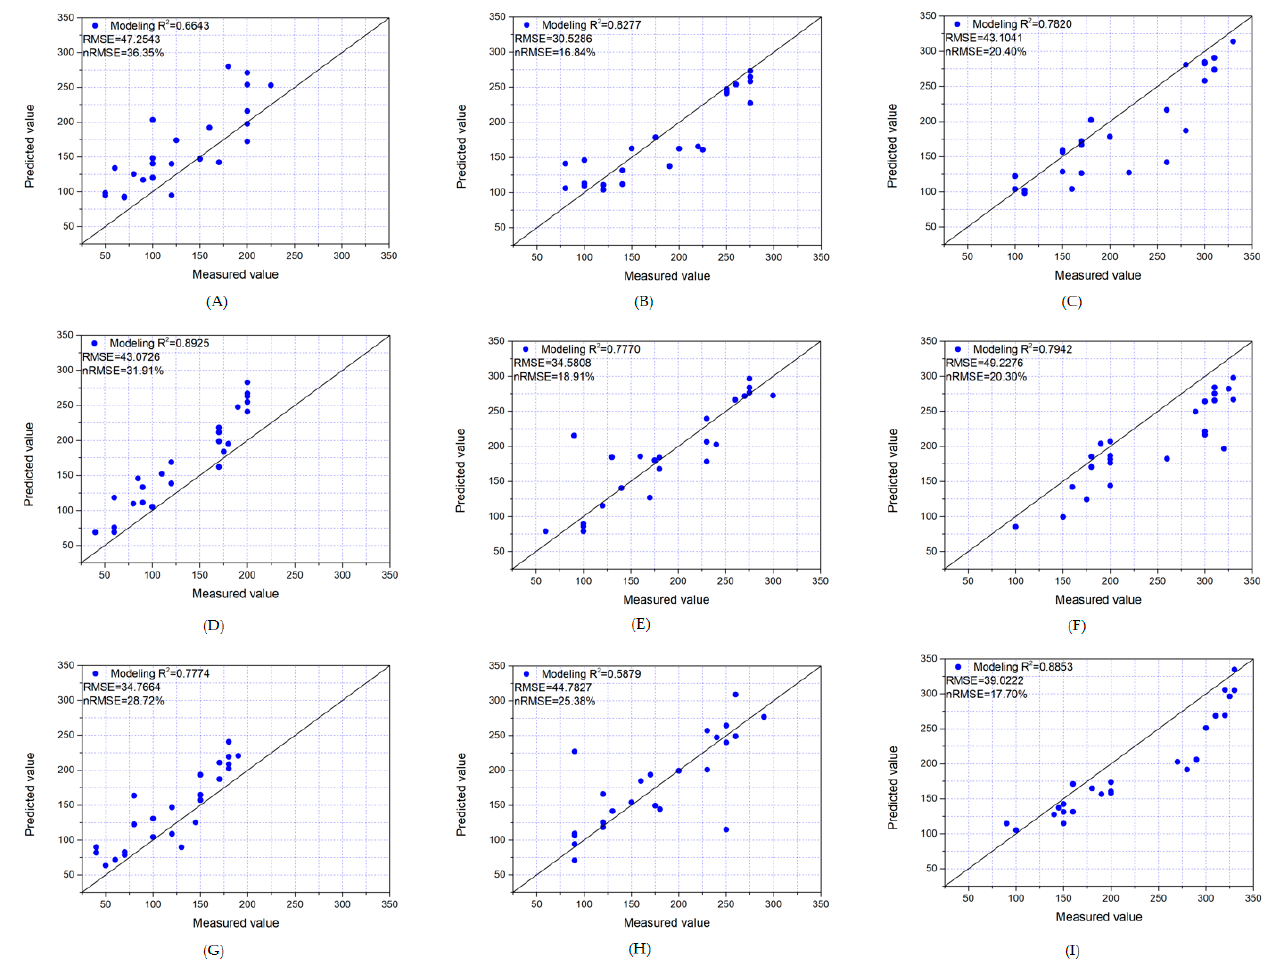
Figure 14. Prediction models for tiller number of different winter wheat varieties under the same density treatment and different nitrogen treatments. ( A – C ) Variety 1; ( D – F ) variety 2; and ( G – I ) variety 3. There were three density treatments: ( A , D , G ) M1; ( B , E , H ) M2; and ( C , F , I ) M3.